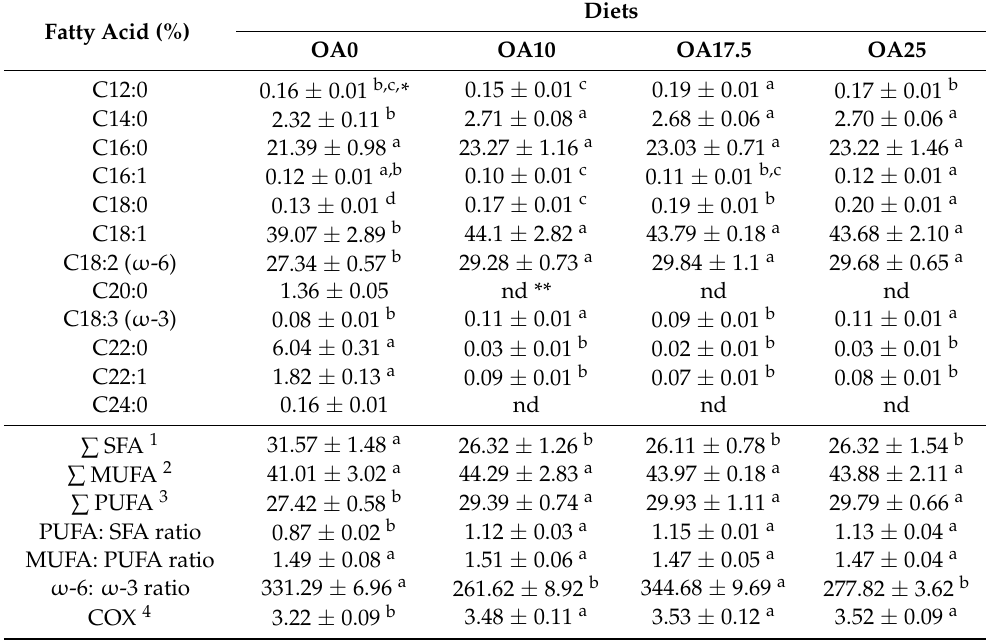
Table 3. Fatty acid composition of Tenebrio molitor larvae fed for six weeks with wheat bran (control) (OA0) and bran fortified with different rates of albedo orange peel waste (10 (OA10), 17.5 (OA17.5), and 25% (OA25)) (n =